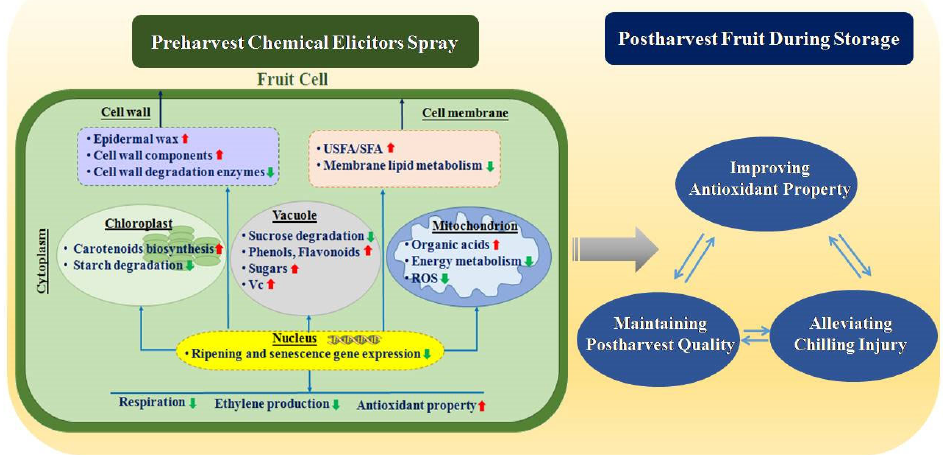
Figure 1. A possible mode of action of preharvest elicitors spray improves antioxidant property, alleviates chilling injury, and maintains quality in harvested fruit. ROS indicates reactive oxygen species; USFS/SFA indicates unsaturated/saturated fatty acids; Vc indicates vitamin C. Due to the rapid cell division and significant cell expansion in fruit during the growth and development stage, the fruit is more sensitive to the stimuli of external